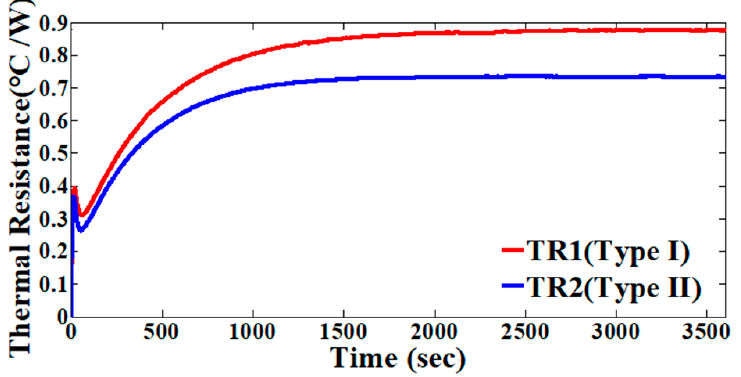
Figure 28. Dummy Heater and cold surface of the TEC temperature response.